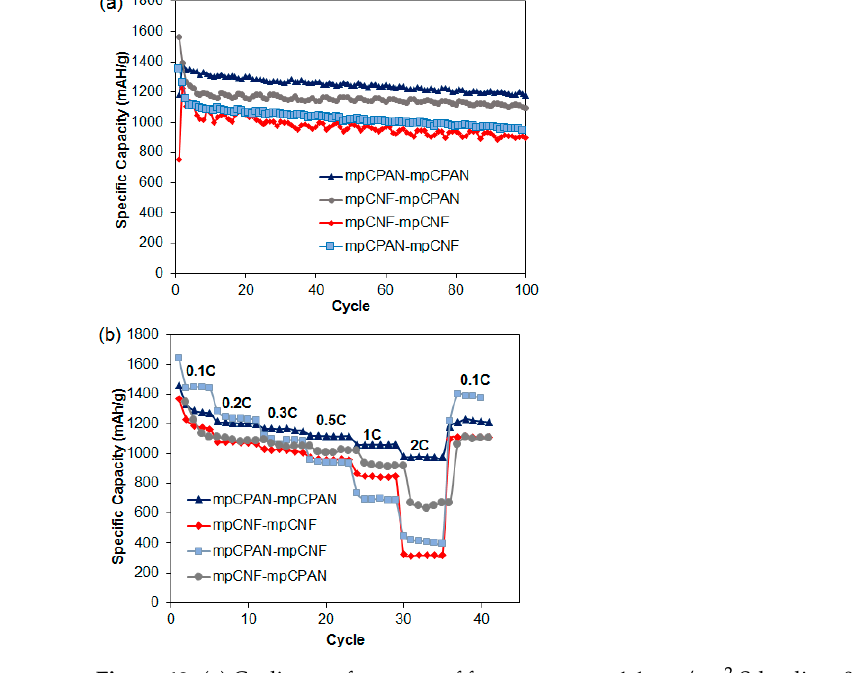
Figure 12. ( a ) Cycling performance of four systems at 1.1 mg/cm 2 S-loading, 0.5 C; ( b ) Rate capability test comparison of systems using mpCPAN as interlayer/cathodes at 1.1 mg/cm 2 S-loading. test comparison of systems using mpCPAN as interlayer/cathodes at 1.1 mg/cm 2